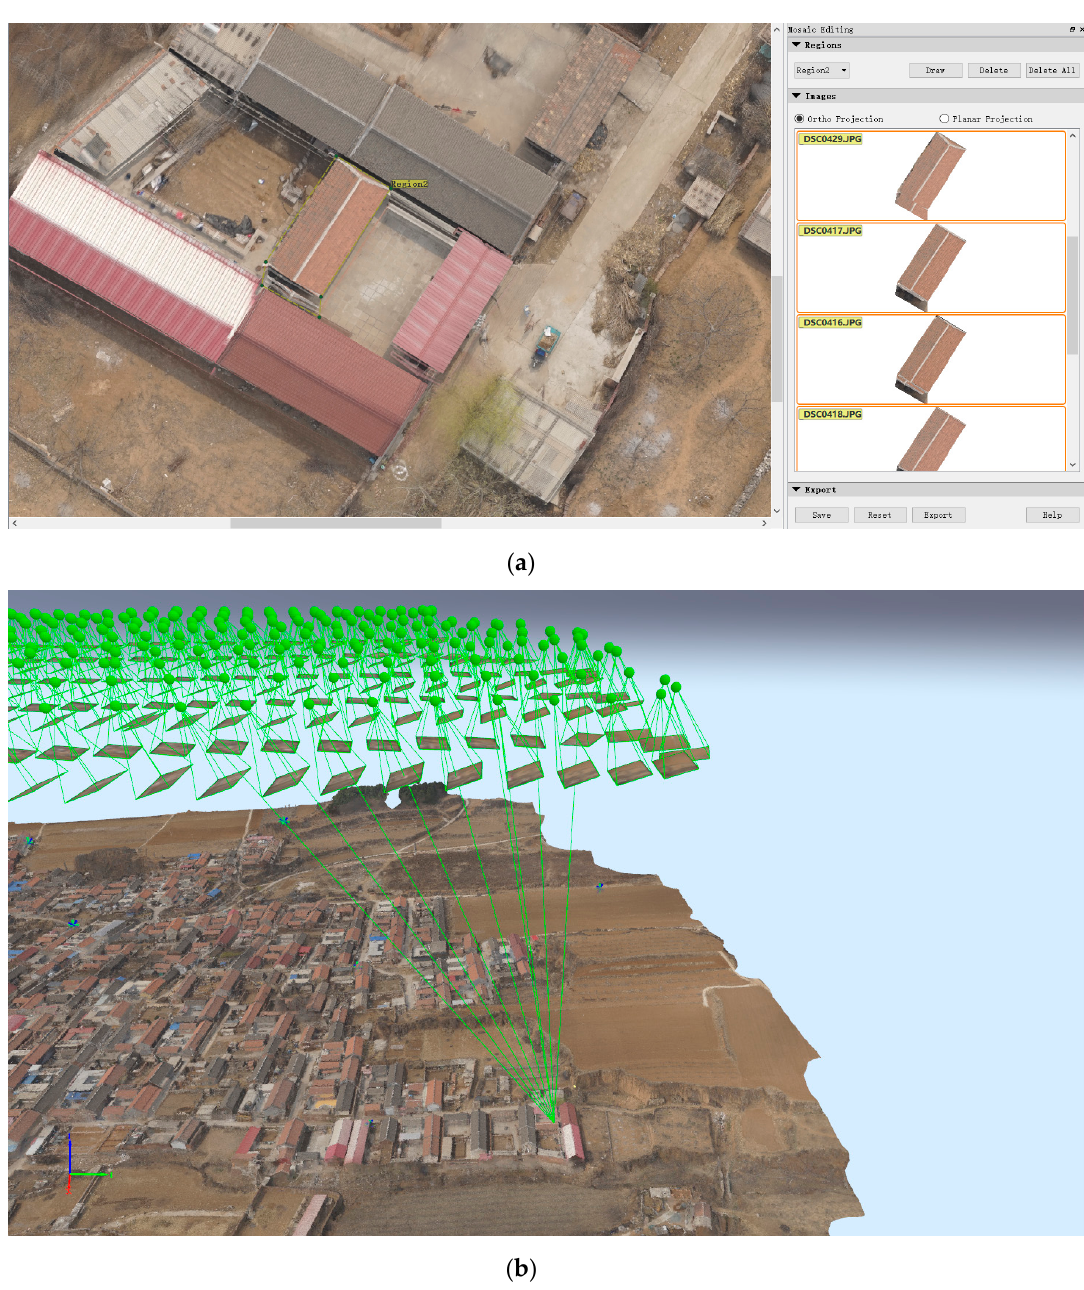
Figure 5. ( a ) The multi-view image compensation operation page; and ( b ) the masked area camera exposure location for multi-view.